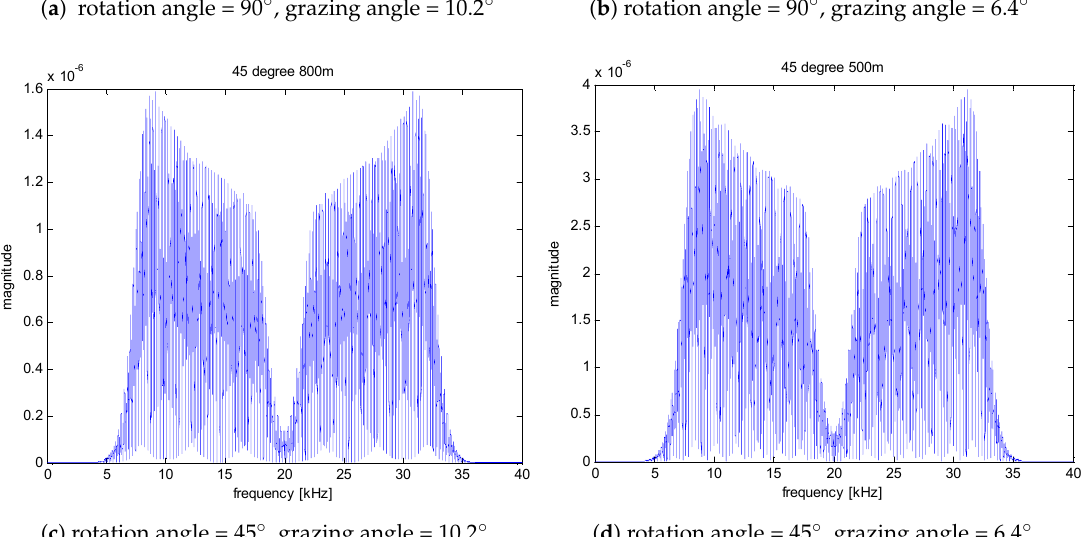
( d ) rotation angle = 45 ◦ , grazing angle = 6.4 ◦